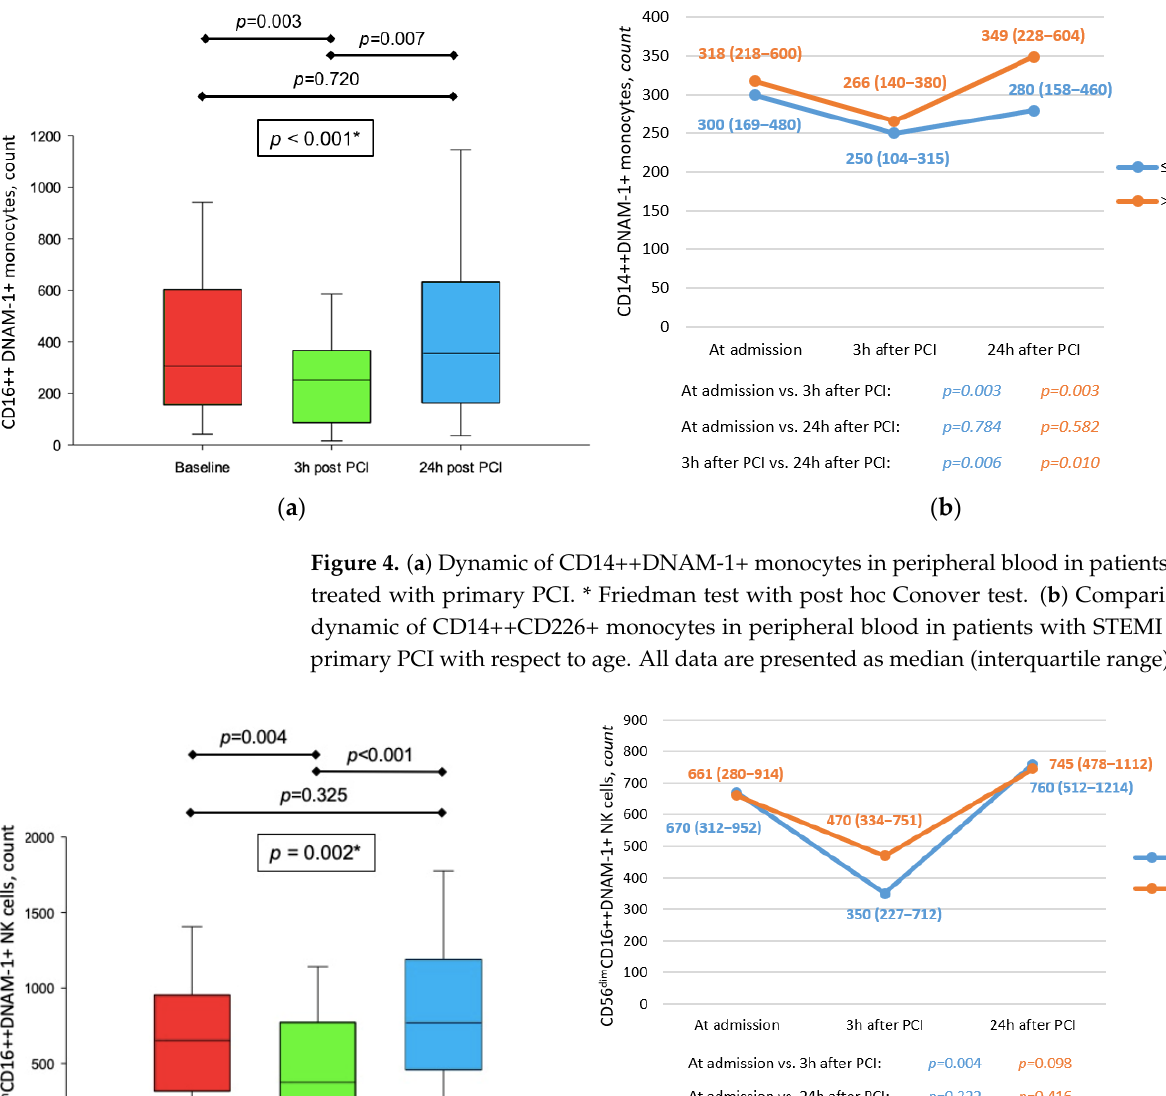
Figure 5. ( a ) Dynamic of CD56dimCD16++DNAM-1+ NK cells in peripheral blood in patients with STEMI treated with primary PCI. * Friedman test with post hoc Conover test. ( b ) Comparison between dynamic of CD56dimCD16++CD226+ NK cells in peripheral blood in patients with STEMI treated with primary PCI with respect to age. All data are presented as median (interquartile range).